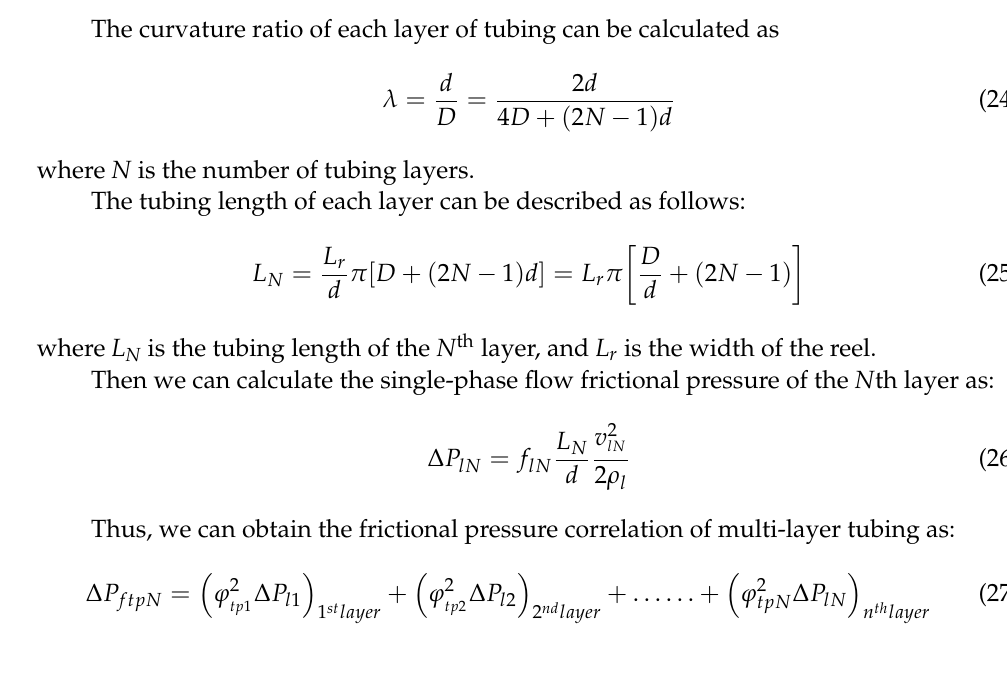
Figure 12. Schematic diagram of multi-layer coiled tubing drum.